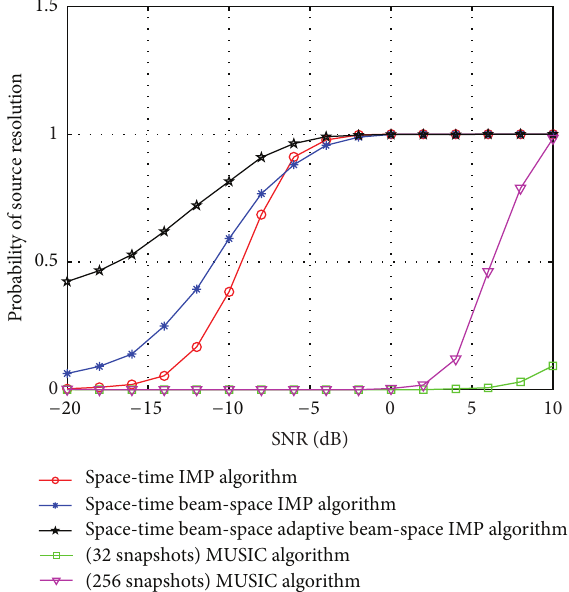
Figure 3: Probability of source resolution versus SNR in azimuth